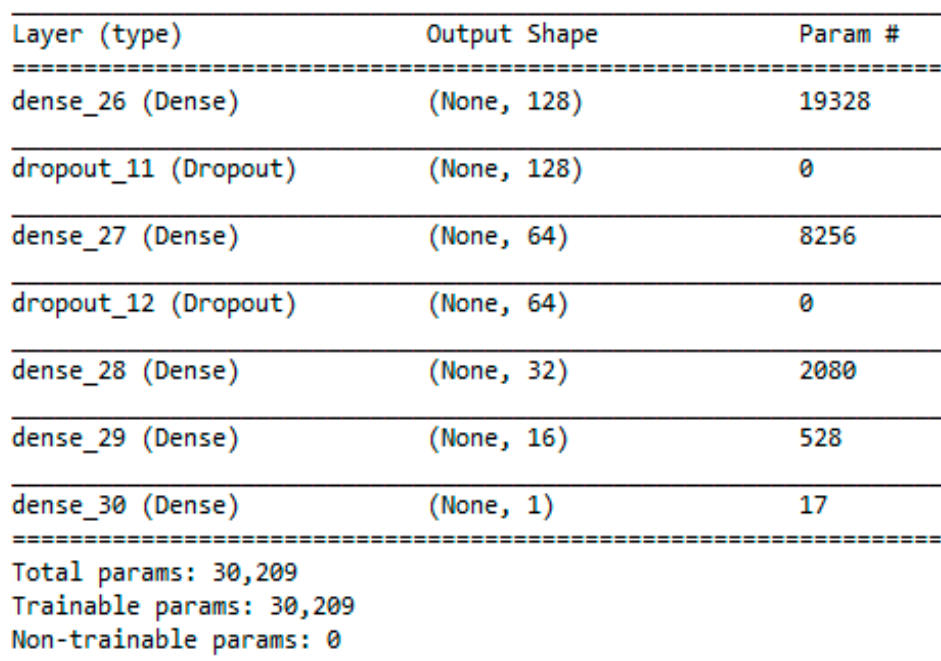
Figure 2. Summary of a single designed deep learner.